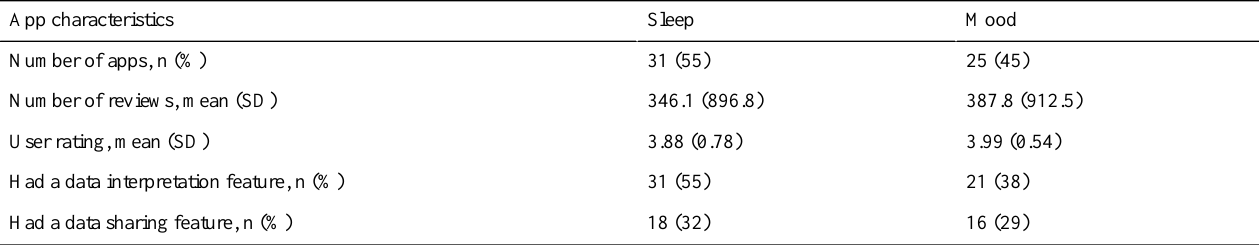
Table 2. Statistical summary of the selected sleep and mood tracking apps. MoodSleepApp